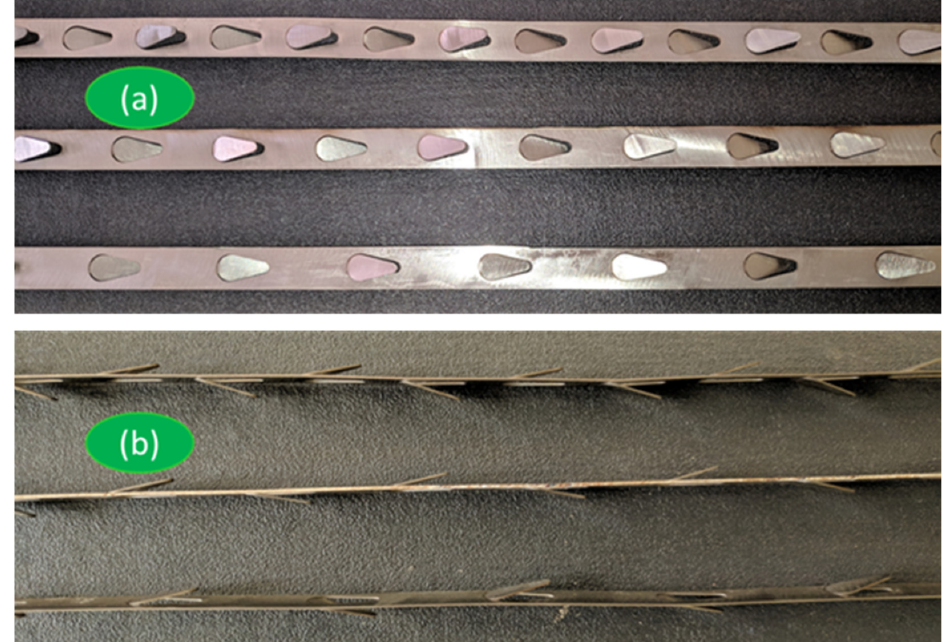
Figure 3. ( a ) Top View of the PWT with different pitches ( b ) Side view of the PWT with different inclinations [29]. inclinations Table 2. Thermophysical properties.